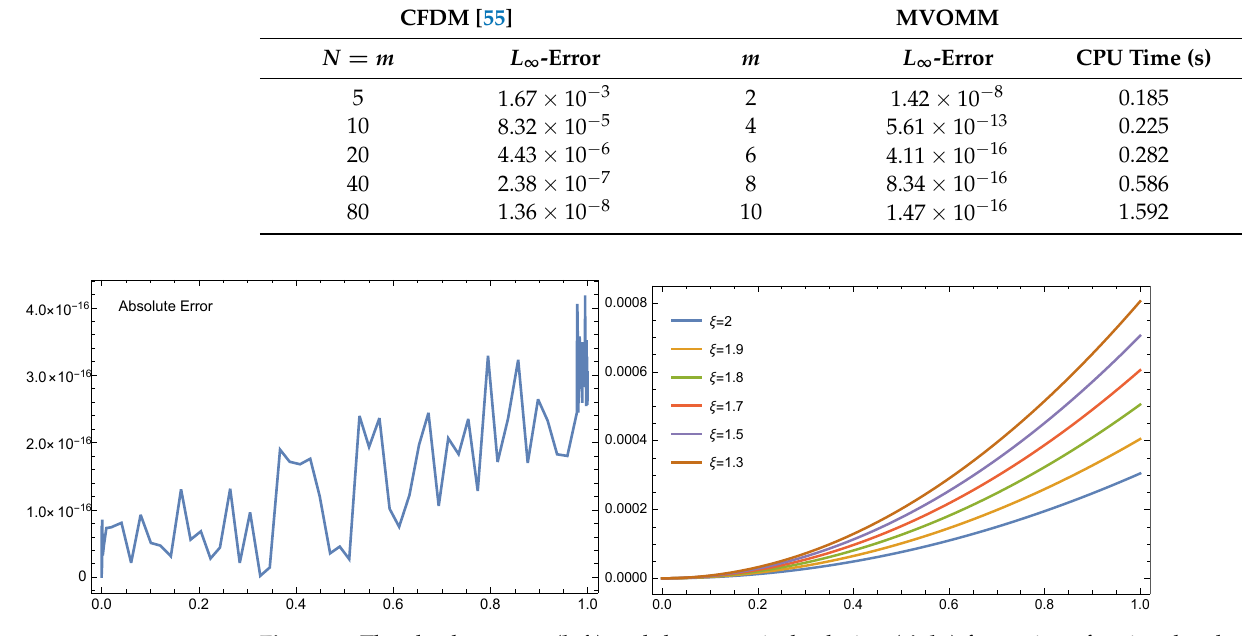
Figure 8. The absolute error ( left ) and the numerical solution ( right ) for various fractional-order cases of ξ for Example 5 with m =